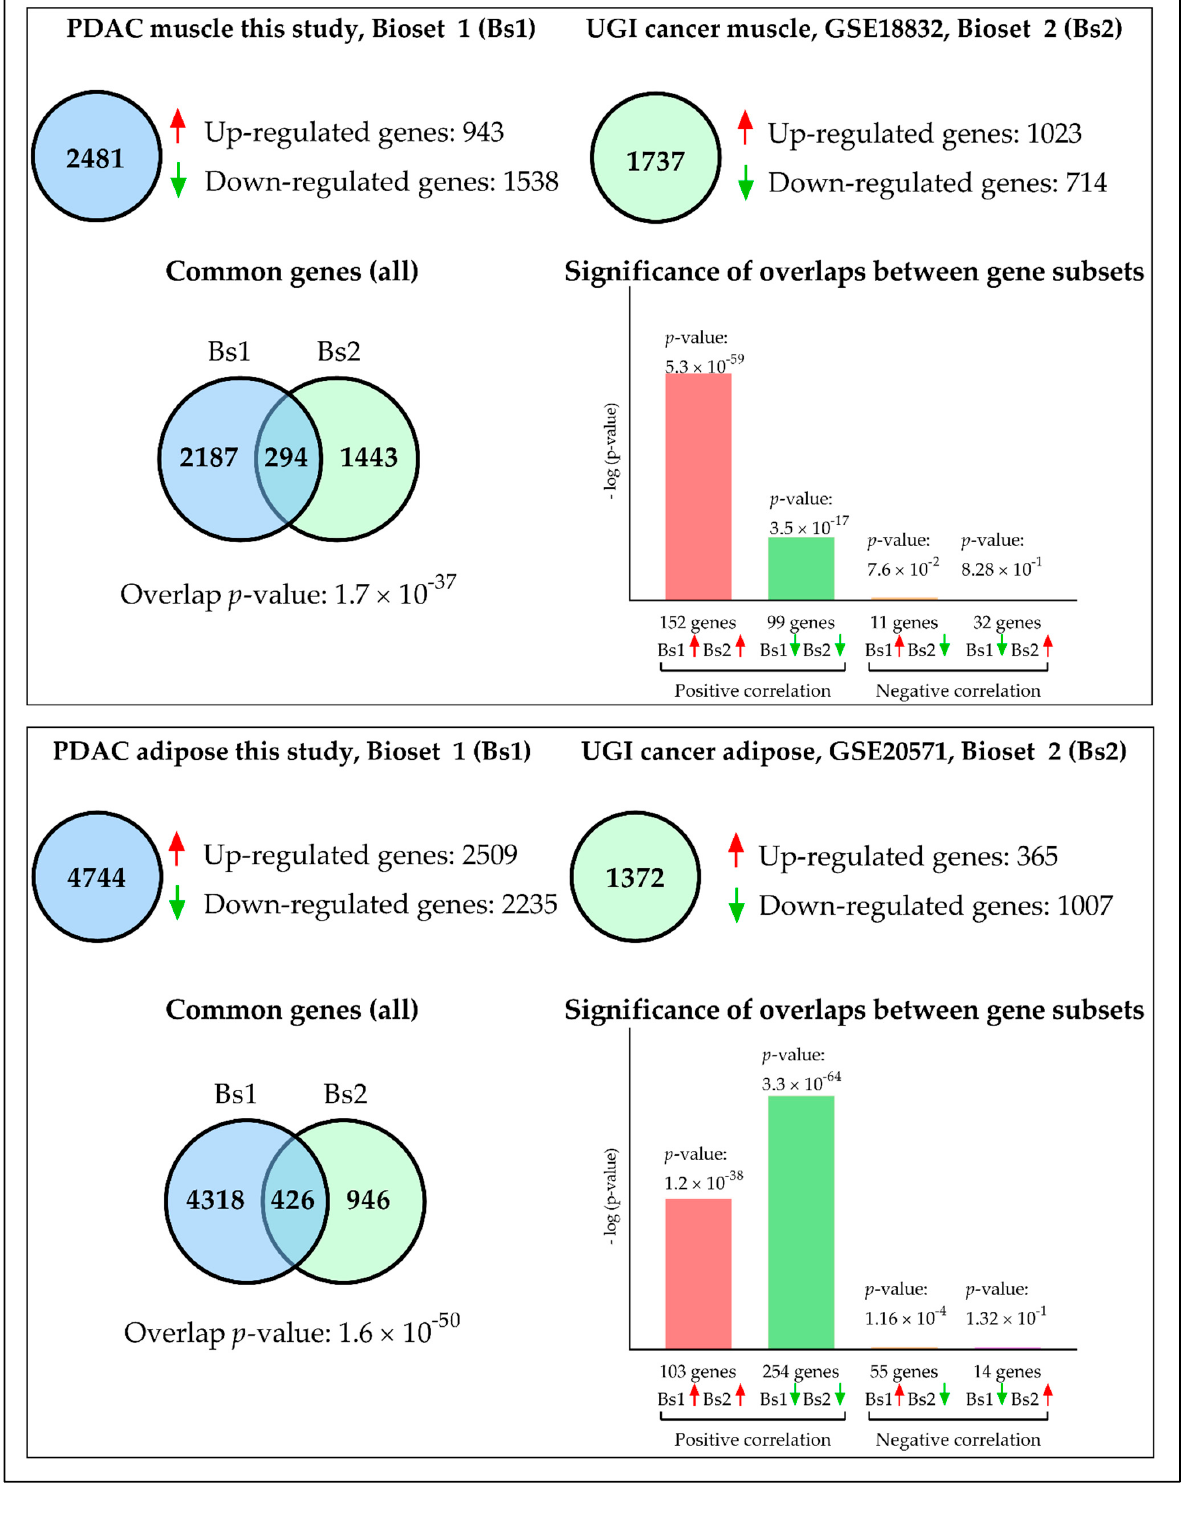
Figure 9. Validation of muscle and adipose DE genes in external dataset. For muscle, 294 genes were common between IU and the external dataset, of which 251 genes had similar direction of effect (~84%). For adipose tissue, 426 genes were common between the two datasets of which 357 genes had similar direction of effect (83%).